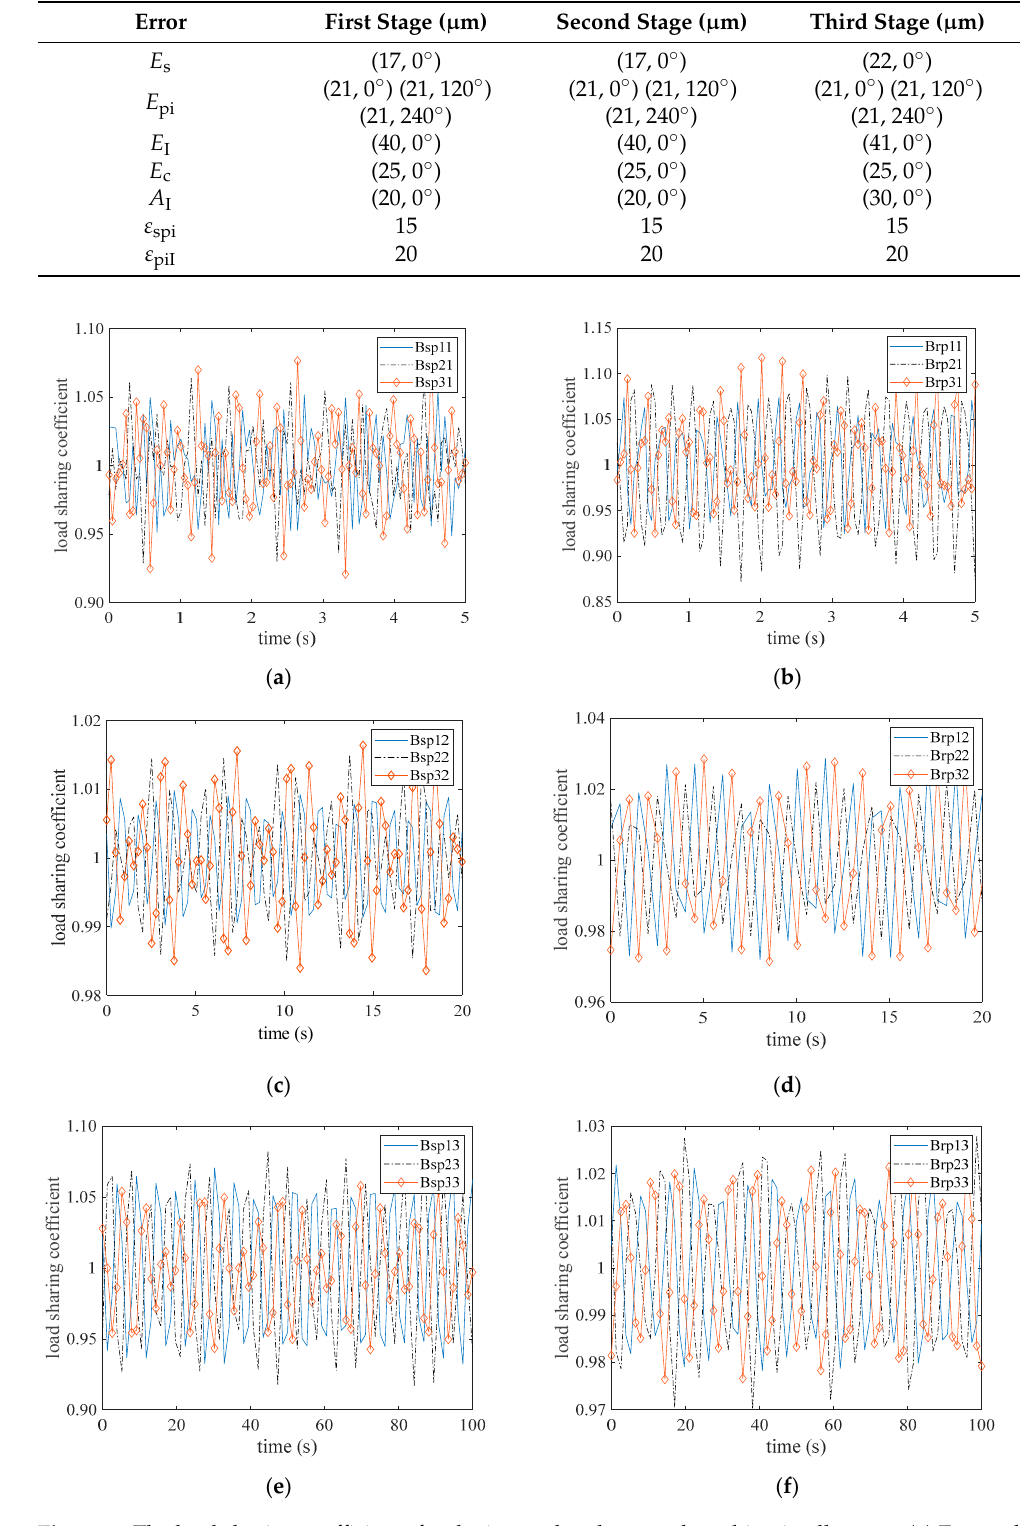
Table 4. The errors of the transmission component in the pitch drive.